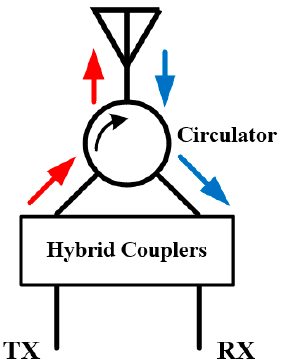
Figure 11. Typical isolation feed network employing circulators and couplers.